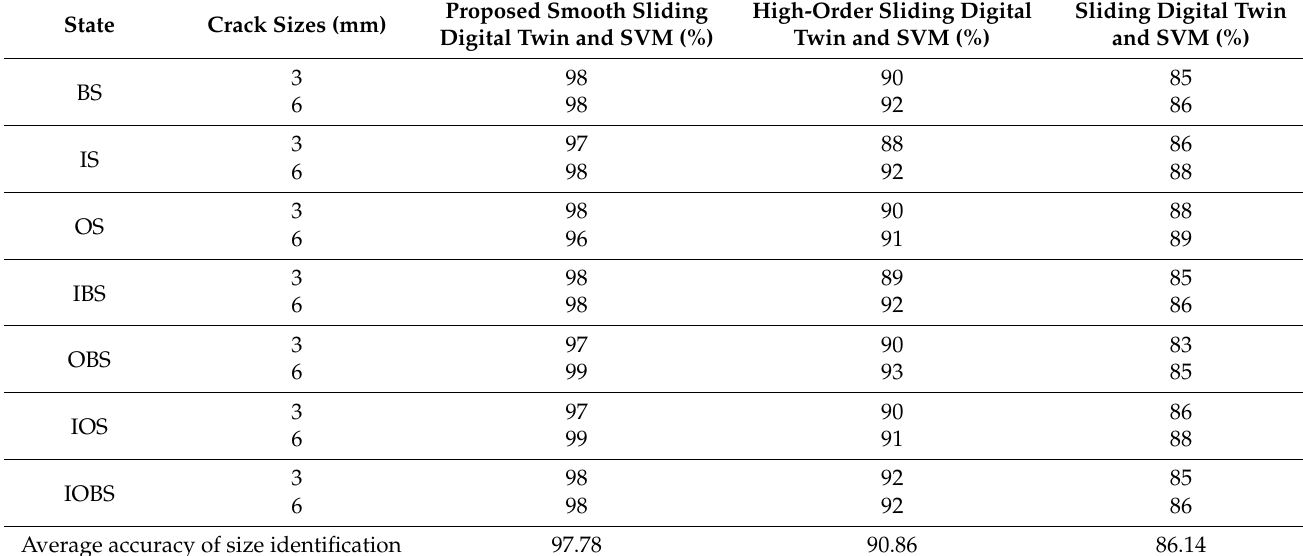
Table 5. Crack size identification accuracy of the residual RMS signals using the combination of the proposed smooth sliding digital twin and SVM, the combination of the high-order sliding digital twin and SVM, and the combination of the sliding digital twin and